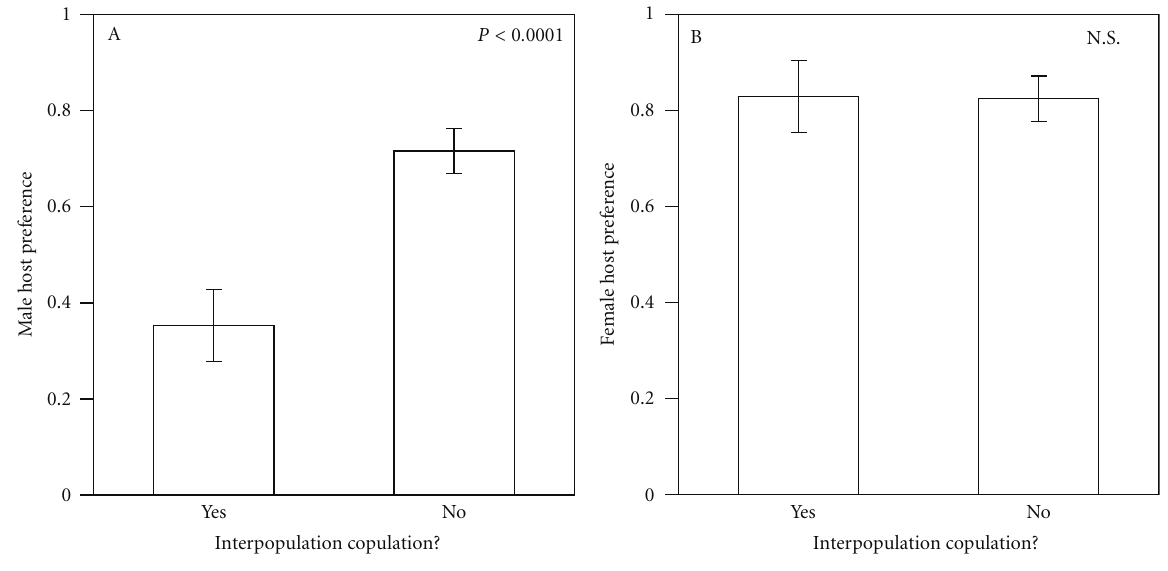
Figure 3: Mean ( ± SE) of relative host preference expressed by individual (A) males and (B) females in the interpopulation ( Q. geminata × Q. virginiana ) mating trials as a function of copulation success. The greater observed host preference of males in those mating trials that did not result in a copulation further support the role of habitat isolation as an important premating reproductive barrier among gall wasp populations.